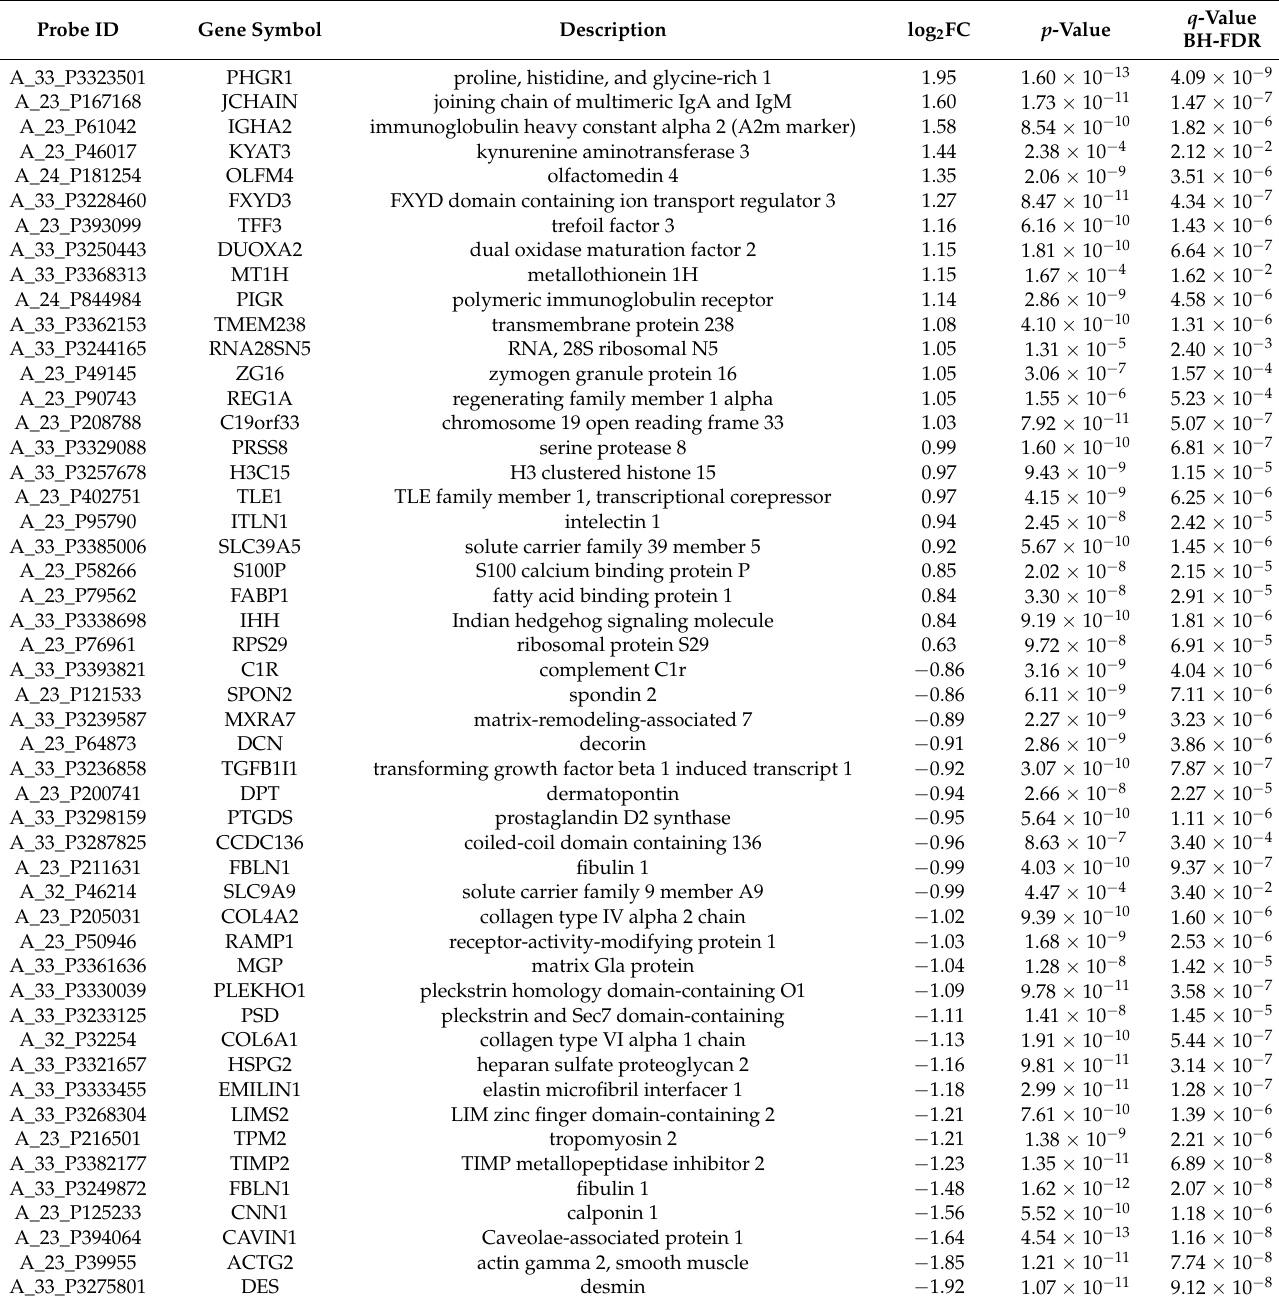
Table 2. Top 50 differentially expressed genes resulting from the statistical comparison of tumour vs. stromal samples (Rank Product, paired design). Positive log 2 FC values indicate overexpression in tumours compared to